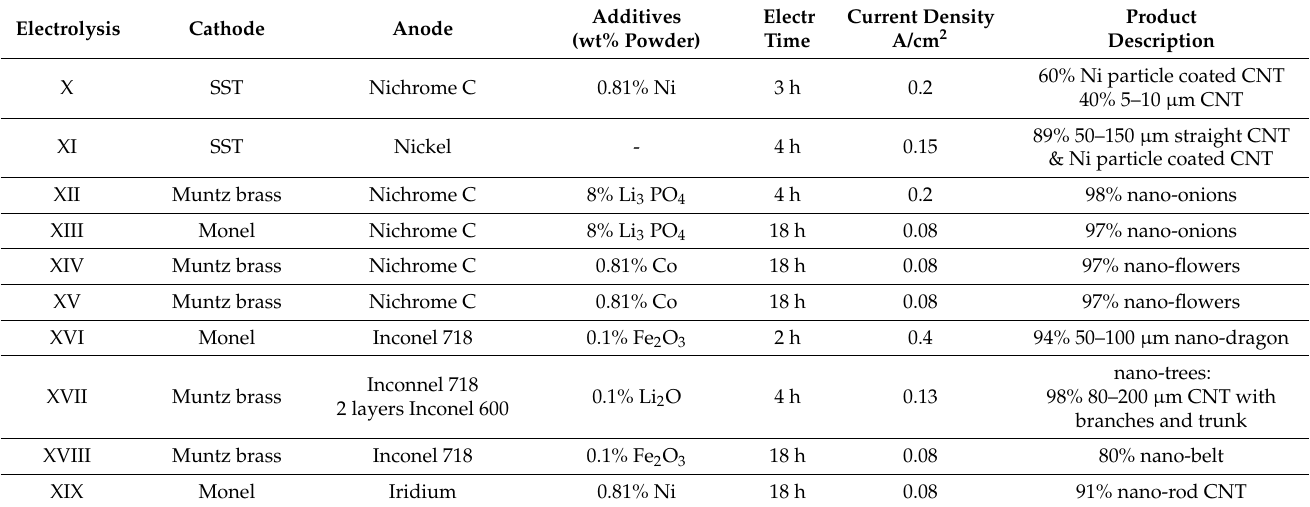
Table 3. Systematic variation of CO 2 splitting conditions in 770 ◦ C Li 2 CO 3 to optimize formation of nickel-coated CNTs and onion, flower, dragon, belt and rod nanocarbon